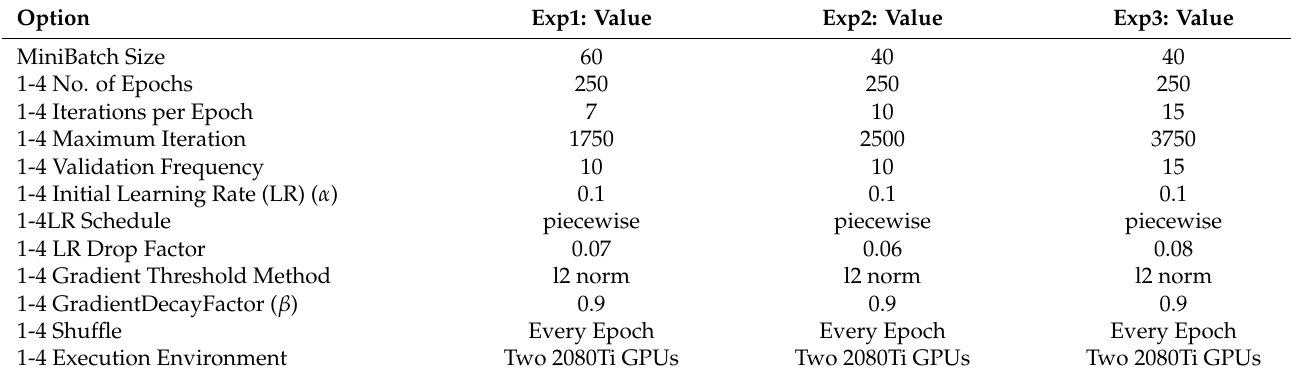
Table 3. Training Parameter Details.